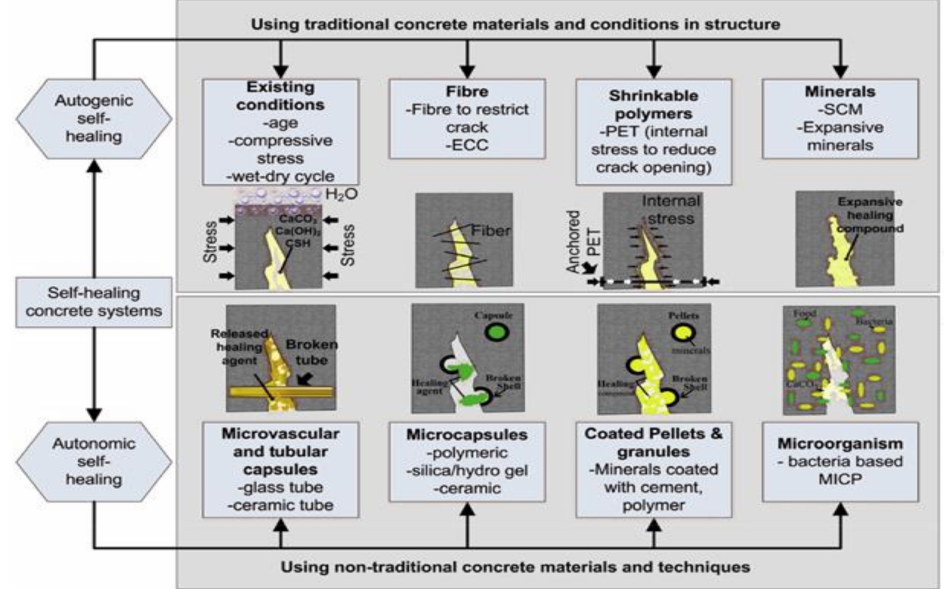
Figure 1. SHC systems (Adapted with permission from MDPI